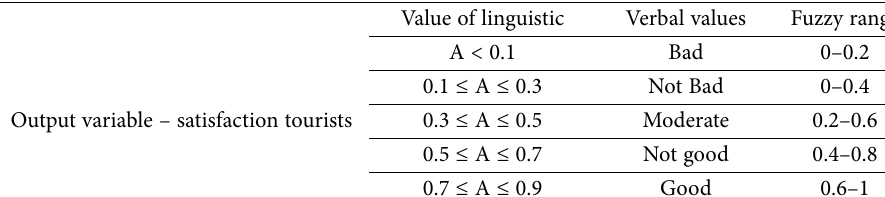
Table 2. Linguistic variable of satisfaction